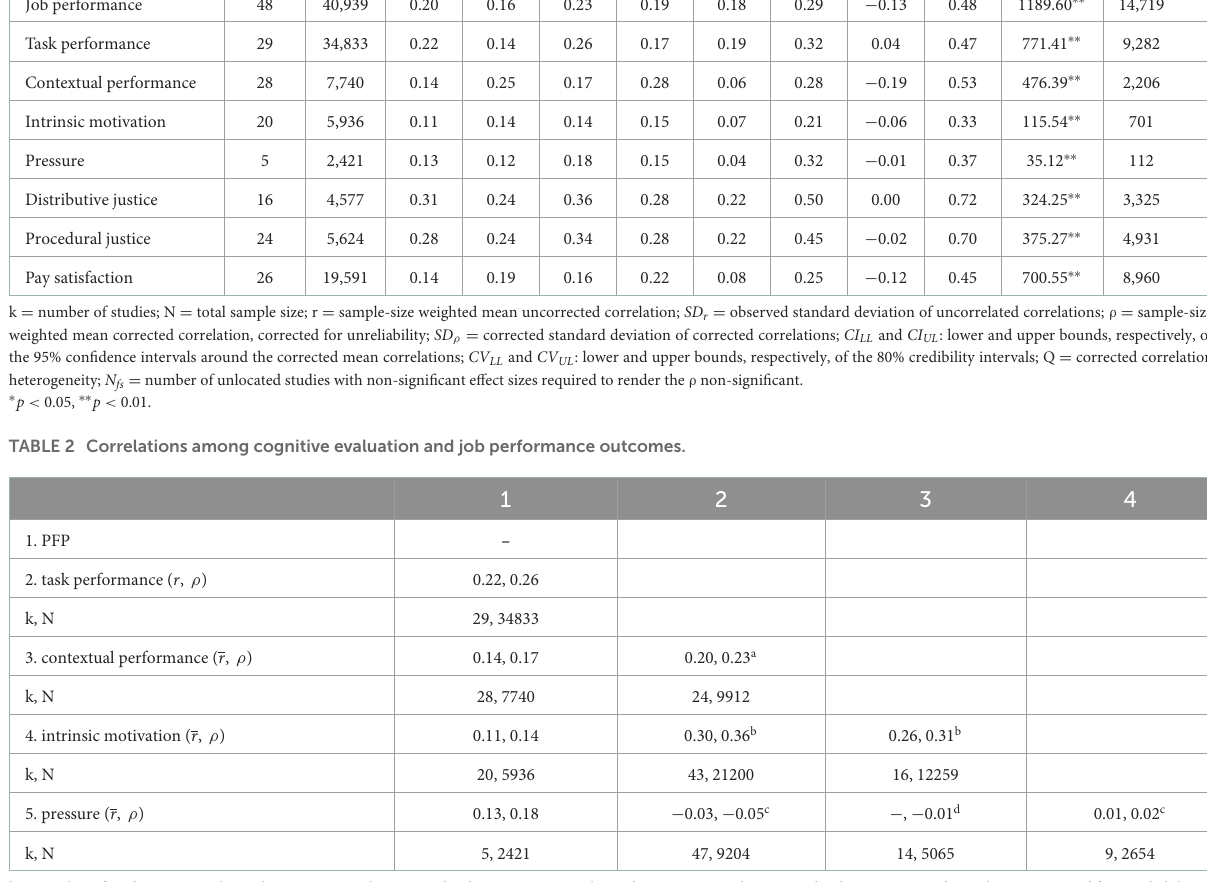
TABLE 1 Meta-analytic results for PFP, job performance and other individual outcomes. Variable